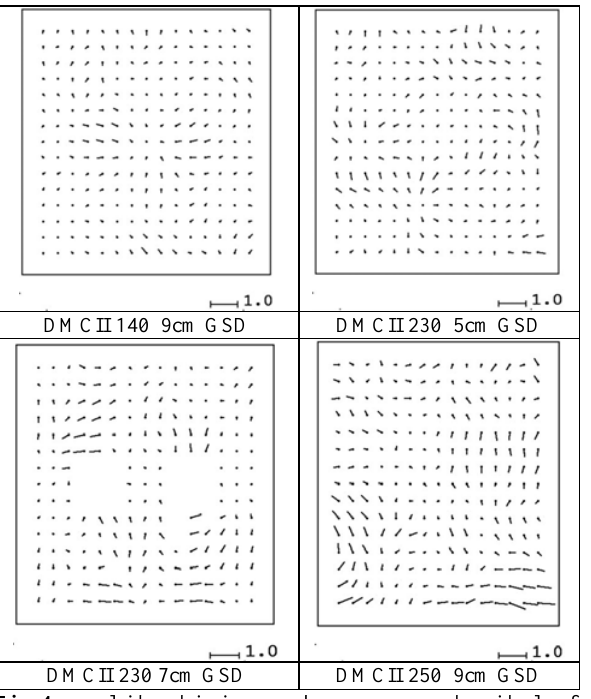
Fig. 4: overlaid and in image sub-areas averaged residuals of bundle block adjustments without self calibration